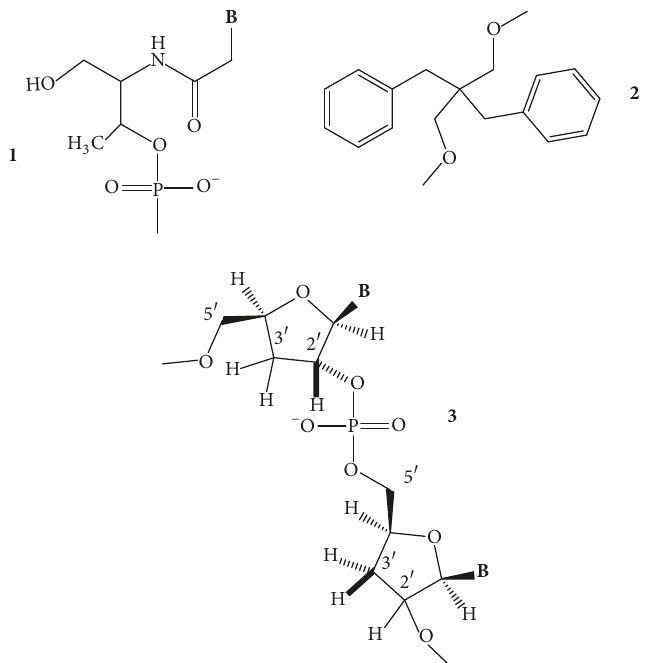
Figure 14: The acyclic threoninol (aTNA) nucleoside ( 1 ); the dibenzyl linker ( 2 ); and a 3 󸀠 -deoxy-2 󸀠 -5 󸀠 - iso -dinucleotide ( 3 ).